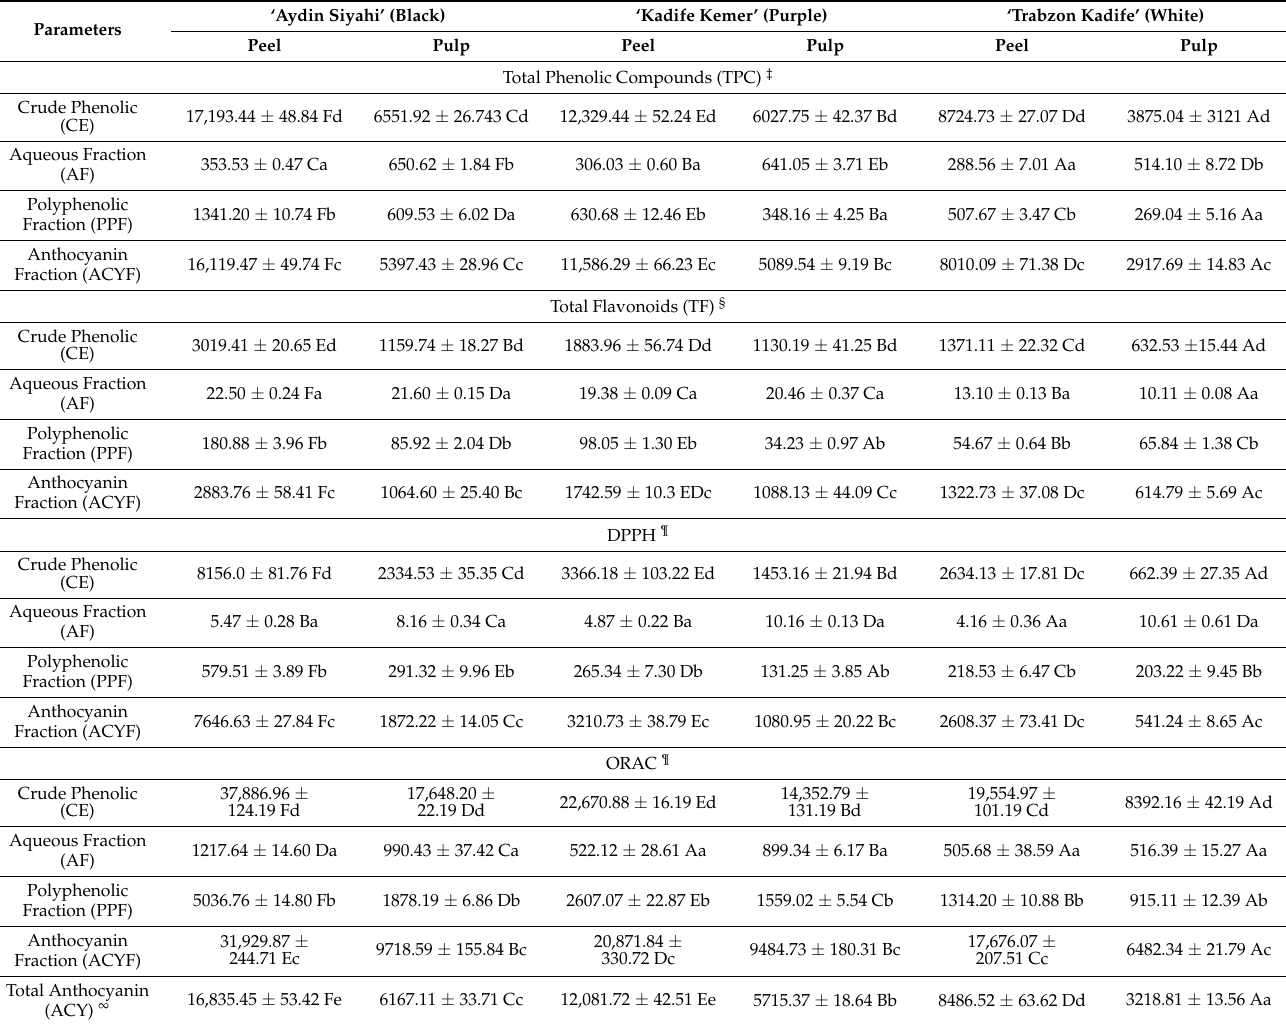
Table 1. Comparison of total phenolic compounds content and antioxidant capacity values in the peel and pulp of common eggplant fruits